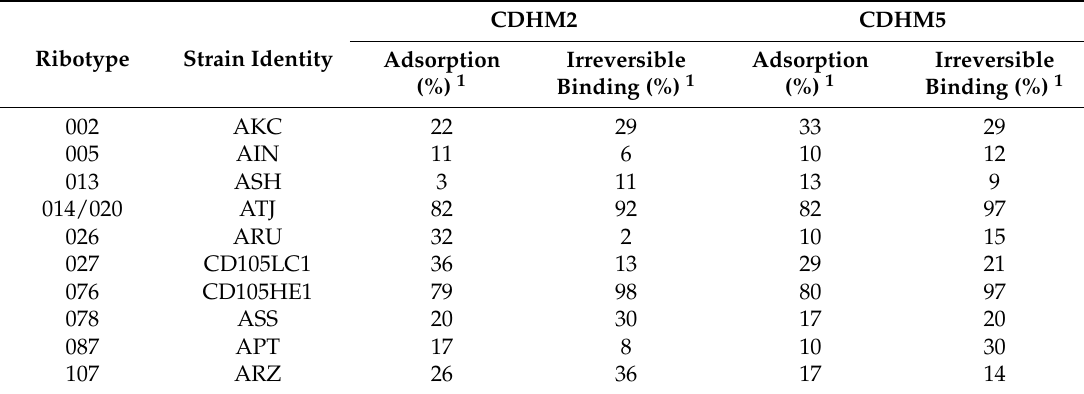
Table 3. The percentage of phages CDHM2 and CDHM5 that adsorbed and irreversibly bound to different clinically relevant C. difficile